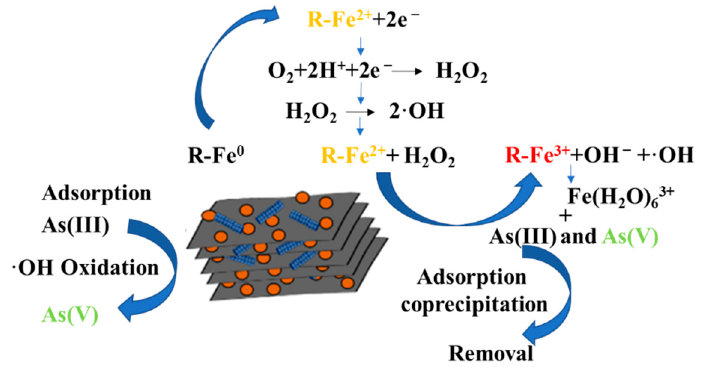
Figure 7. The possible removal mechanism of As(III) by nZVI/MXene@CNTs.